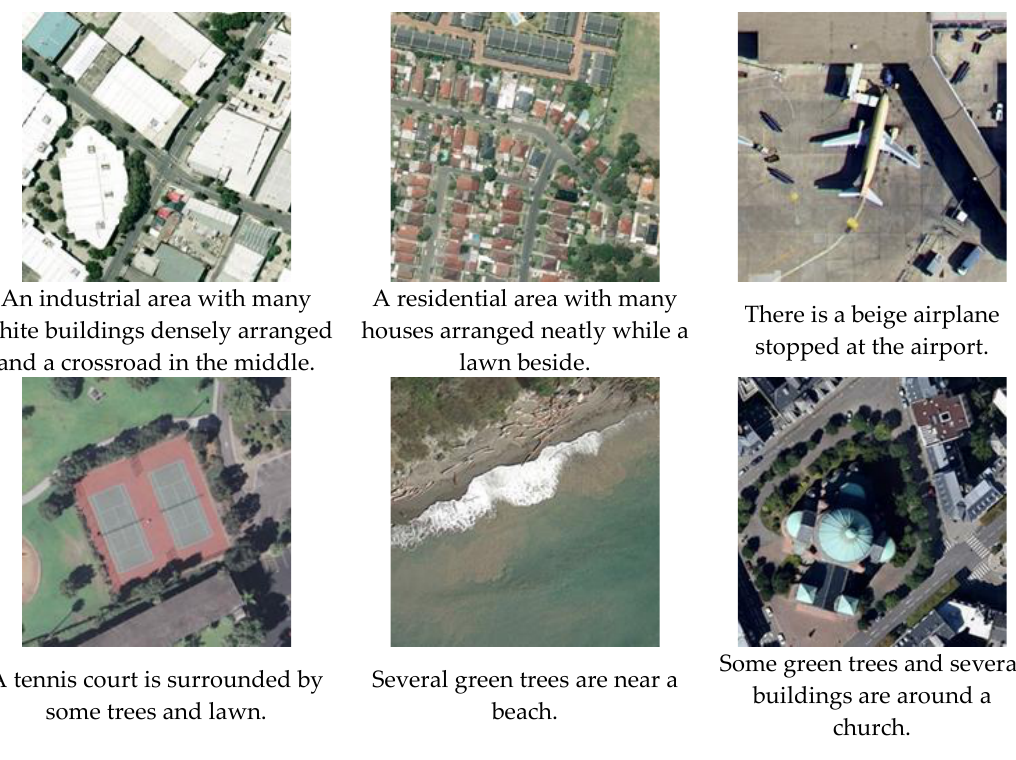
Figure 9. Generated sentences not present in the training dataset.